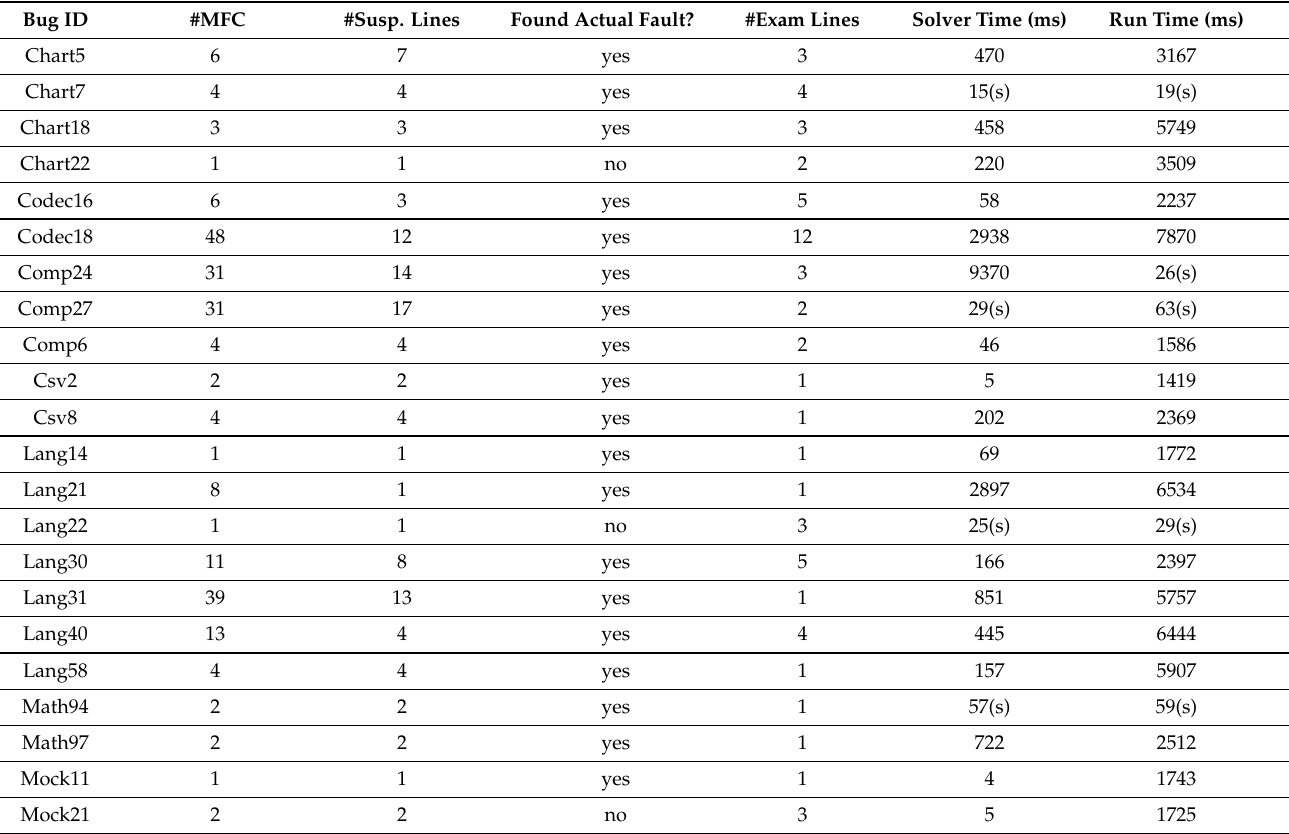
Table 4. Fault localization results of AgxFaults for real